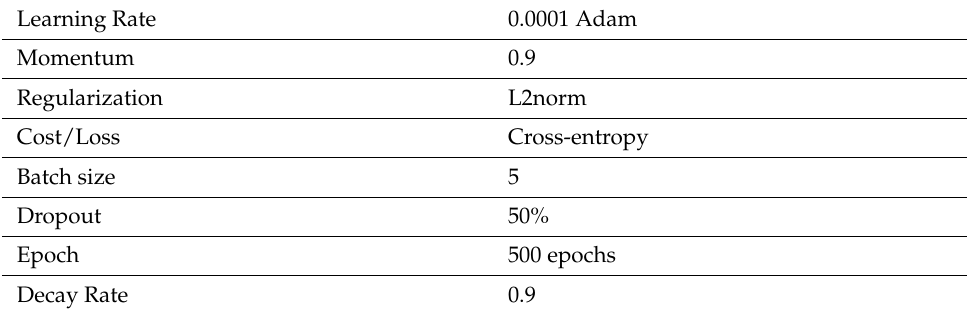
Table 1. Hyperparameters used for